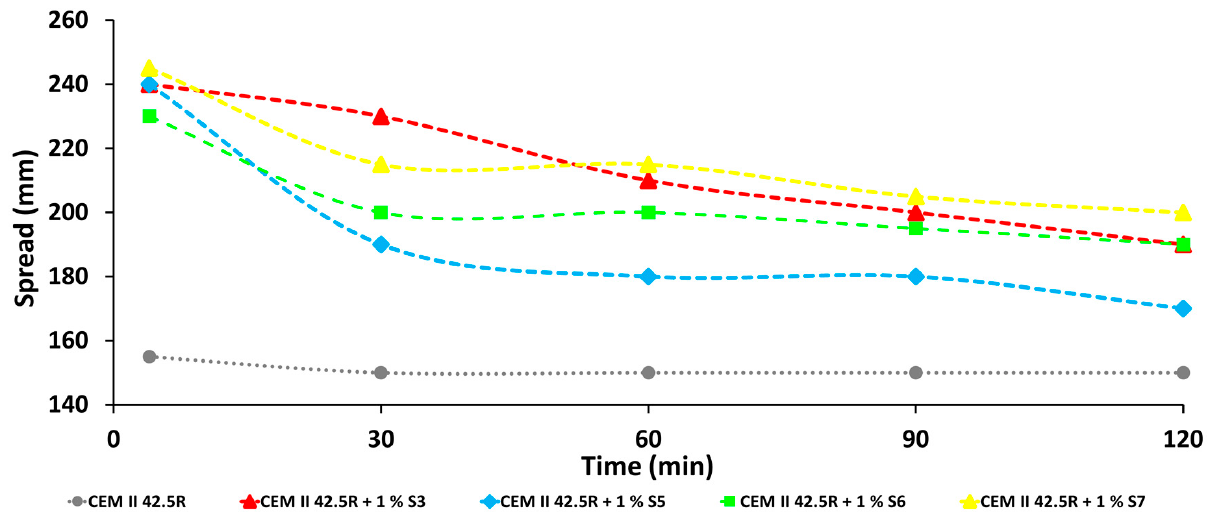
Figure 9. Evaluation of the fluidification properties through slump test of CEM II 42.5 R doped with and 1% bwoc of additives with a w/c = 0.5 (DIN EN 197-1).